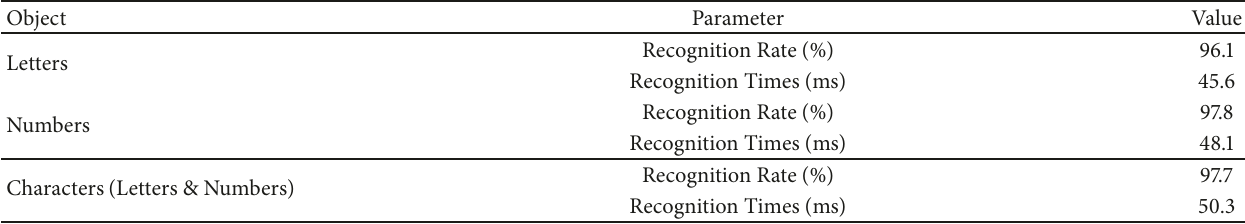
Table 1: Identification performance of each character.